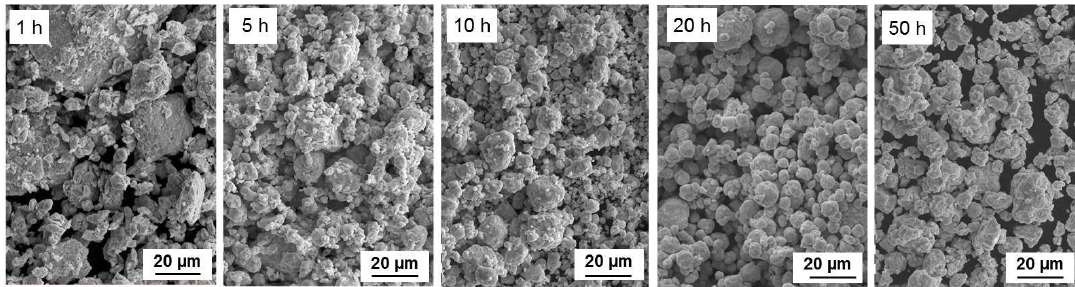
Figure 5. Morphological evolution of Mo-9Si-8B particles depending on the state of MA using steel balls and vials and 200 rpm.